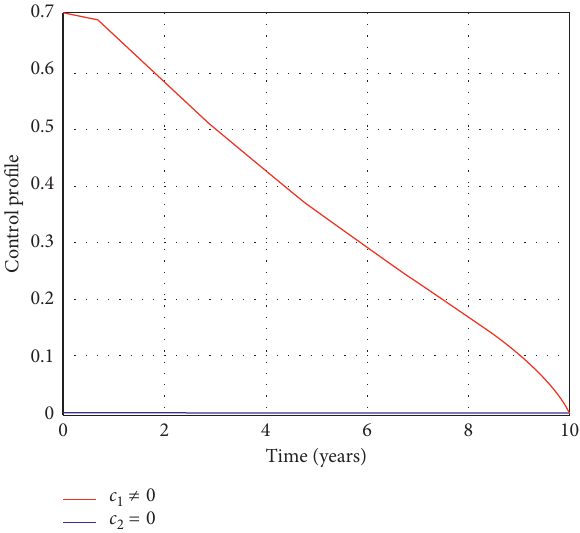
Figure 5: Control profile when c